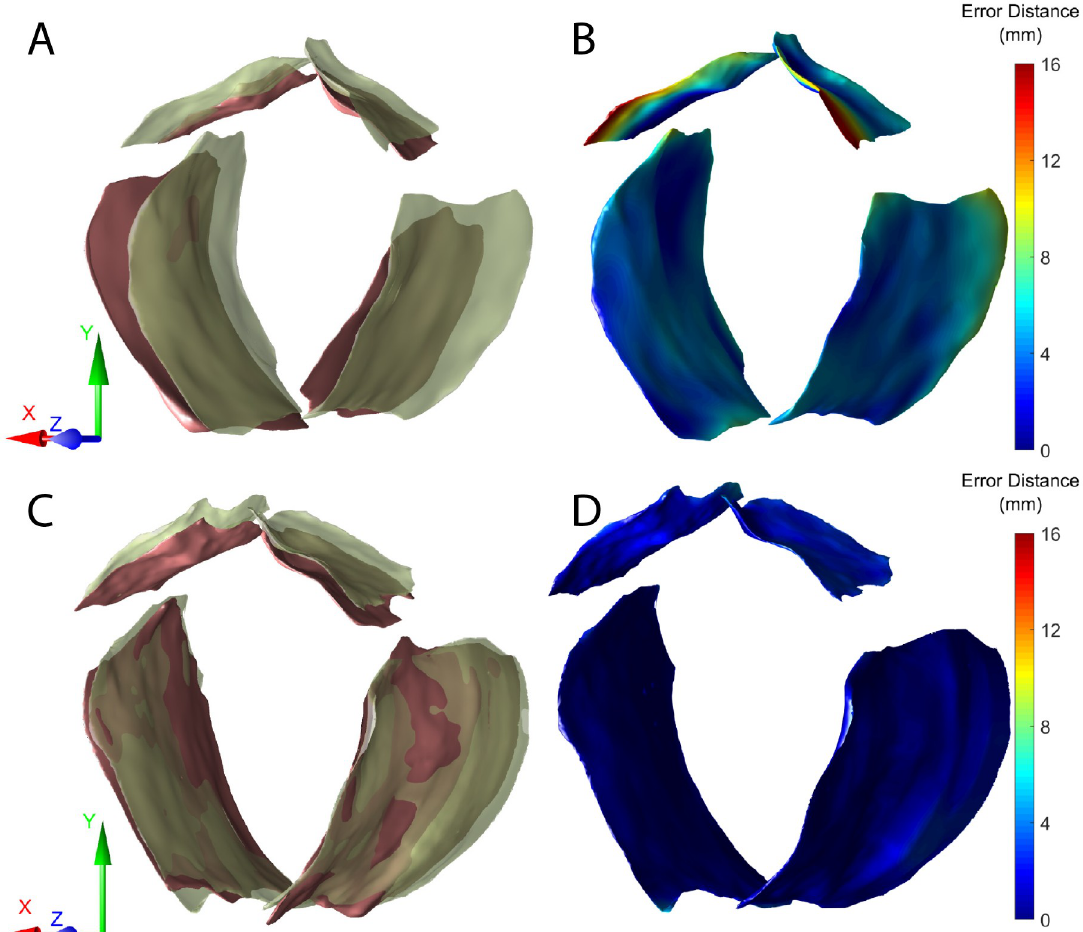
Fig 9. Comparison of the reconstructed pubic bone and levator ani muscle surfaces before and after applying M3VR. (A) Pubic bone and levator ani muscle surfaces before registration. (C) Pubic bone and levator ani muscle surfaces after registration. Red: surfaces reconstructed from fixed ultrasound volume; green: surfaces reconstructed from moving ultrasound volume. Visualization of one-side error distances from the reconstructed moving surface (green) to reconstructed fixed surface (red) before (B) and after (D) applying M3VR. Error distance are visualized using a blue-green-red colormap with blue corresponding to smaller error and red to larger error.